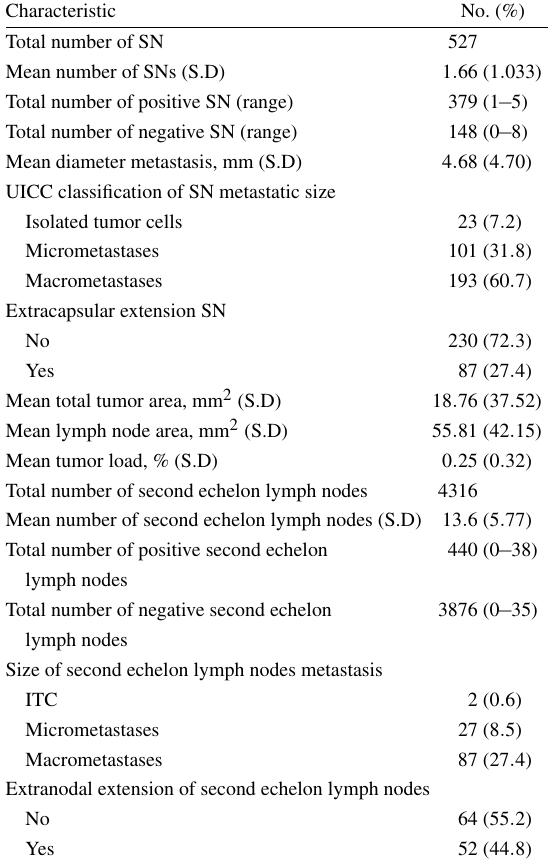
SN and second echelon lymph node characteristics of invasive breast cancer patients with a positive SN and